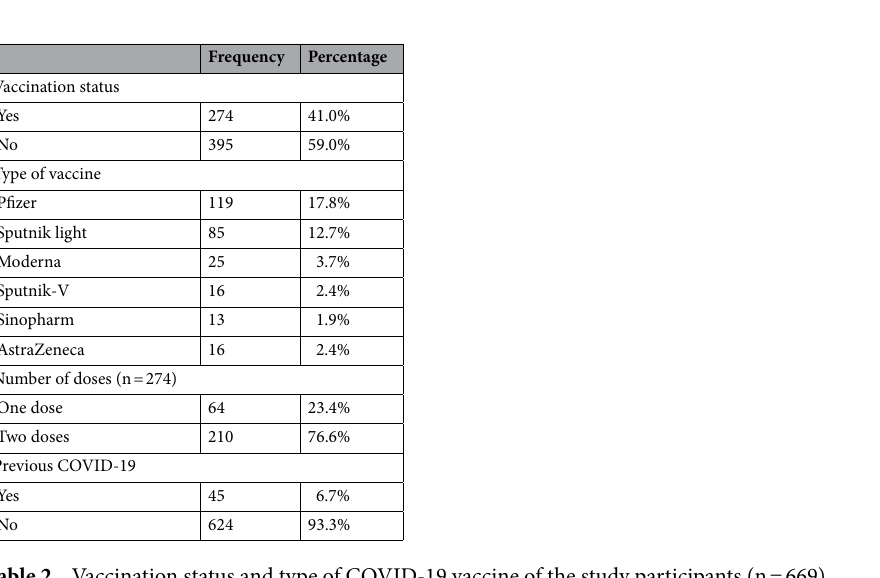
Table 2. Vaccination status and type of COVID-19 vaccine of the study participants (n = 669).